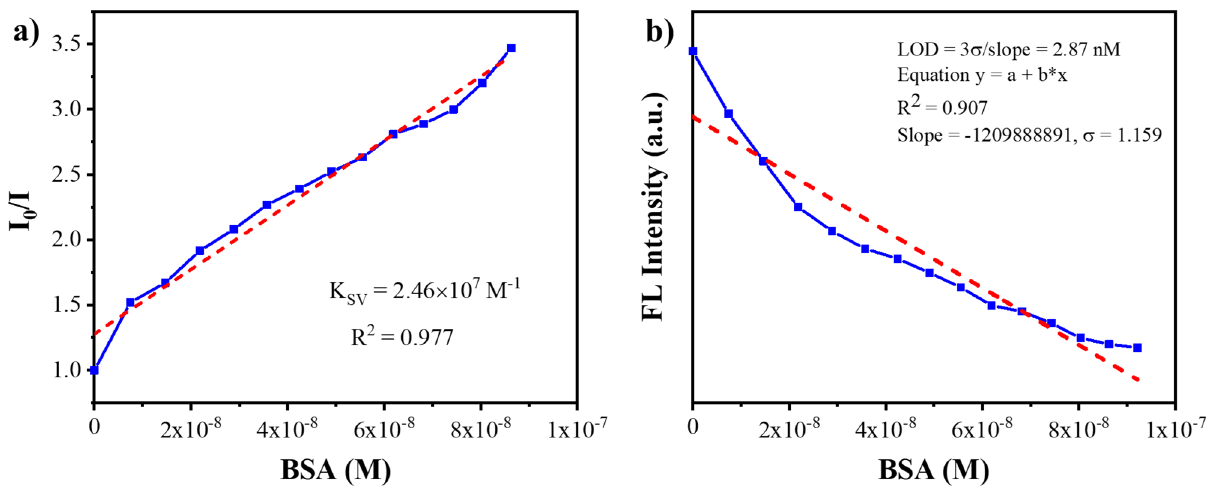
Figure 7. ( a ) Stern–Volmer plot for TPE-kana 1 with BSA and (b) Plot for the determination of the limit of detection (LOD) for